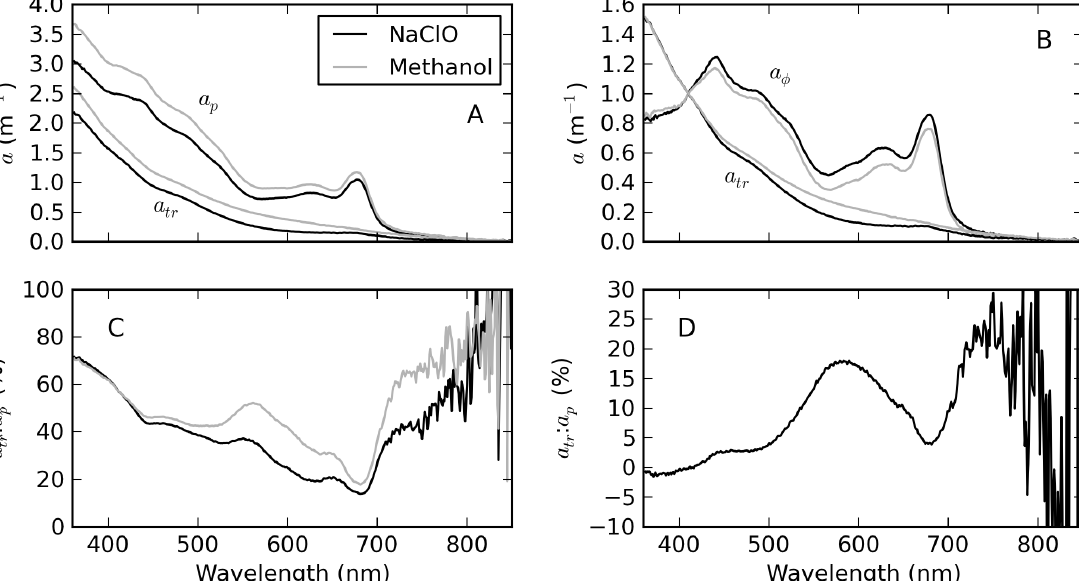
Figure 7. Comparison between NaClO and hot methanol methods for determining a